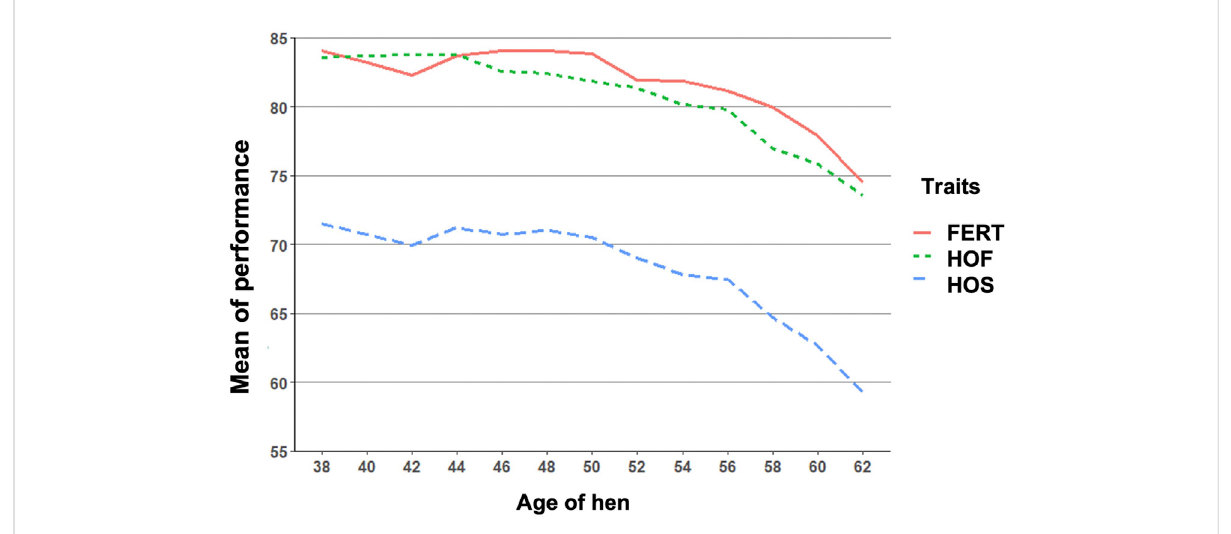
FIGURE 1 Biweekly mean of fertility of set (FERT), hatch of fertile (HOF), and hatch of set (HOS) from 38 to 62 weeks of hen age when records were